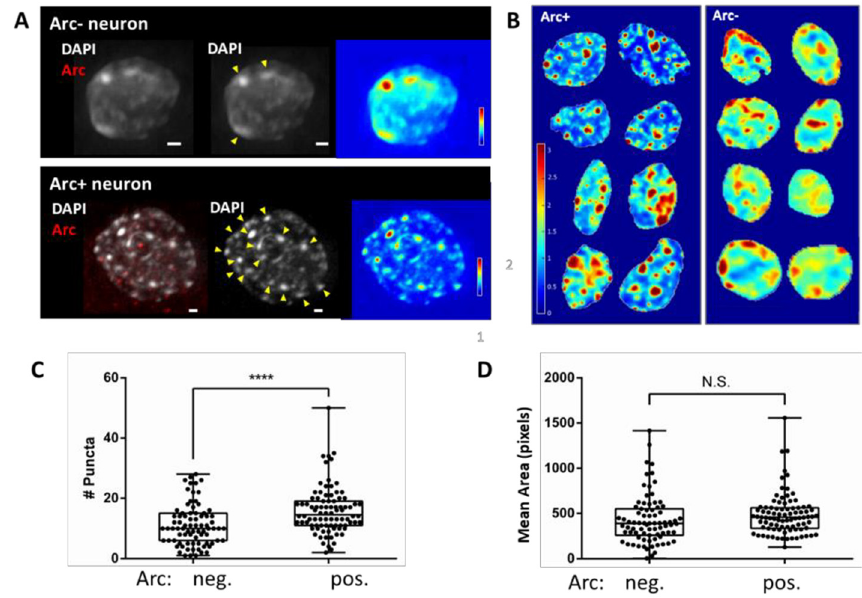
Figure 2. Chromatin reorganisation in Arc-positive neurons. Arc expression was induced in a subset of cultured hippocampal neurons by a 4 h treatment with 4BF . Cells were fixed and stained for Arc (C7 antibody, Santa Cruz). DNA was labelled using DAPI. Z-stacks of DAPI images were obtained for neuronal nuclei that were positive and negative for Arc expression. Out-of-focus fluorescence was removed using 3D deconvolution (AutoQuant). ( A ) Max-projection images of a representative nucleus from an Arc-negative ( top ) and Arc- positive neuron ( bottom ). The white bar indicates a scale bar of 1 µm. DNA, labelled by DAPI, is shown in white while Arc expression is shown in red. Yellow arrowheads indicate DNA puncta. Heat maps of the relative DAPI intensity of the nucleus are shown in the rightmost panels. ( B ) DAPI heat maps for nuclei of 8 Arc-positive and 8 Arc-negative neurons. Relative DAPI intensity is shown by the colour scale on the left, which was the same for both panels. Whereas chromatin of Arc-negative neurons ( right panel) was relatively homogenous (turquoise, green and yellow), Arc-positive neurons ( left panel) were characterised by several areas of high DAPI intensity (red), indicating condensed heterochromatin (chromocenters)-separating domains with decondensed euchromatin (blue). ( C , D ) Puncta were quantified based on their size and intensity. Arc expression, measured as mean Arc intensity, was used to correlate with the properties of the puncta, generating the boxplots. Boxplots of number of puncta ( C ) and area of puncta ( D ) for Arc-negative and Arc-positive neurons. Each ● represents the ( C ) number or ( D ) mean area of puncta in a nucleus. A total of 167 nuclei were analysed from three sets of independent experiments. ( C ) Nuclei of Arc-positive neurons have a significantly higher number of puncta with 11.1 ± 0.8 puncta in Arc-negative nuclei and 15.9 ± 0.8 puncta in Arc-positive nuclei. **** indicates p -value < 0.0001, unpaired t test. ( D ) No significant change in area of puncta was observed: Arc-positive had an area of 488 ± 25 pixels, while the area of Arc -negative neurons was 431 ± 30 pixels ( p = 0.15, unpaired t test). N.S. indicates not significant. labelling DNA with the fluorescent dye 4 ′ ,6-diamidino-2-phenylindole (DAPI). Whereas chromatin in Arc-negative neurons is relatively homogenous, the nuclei of Arc- positive neurons contain many bright puncta, representing chromocenters with densely packed chromatin, in which genes are likely silenced (Figure 2A,B). The puncta are interspersed with domains of highly open chromatin, which is more supportive of efficient gene transcription. The number of puncta increased from 11.1 ± 0.8 puncta in Arc- negative nuclei to 15.9 ± 0.8 puncta in Arc-positive nuclei (Figure 2C). However, the mean area of the puncta was not significantly different between Arc-positive and Arc-negative neurons (Figure 2D). 3.2. Arc Associates with Dynamic Chromatin